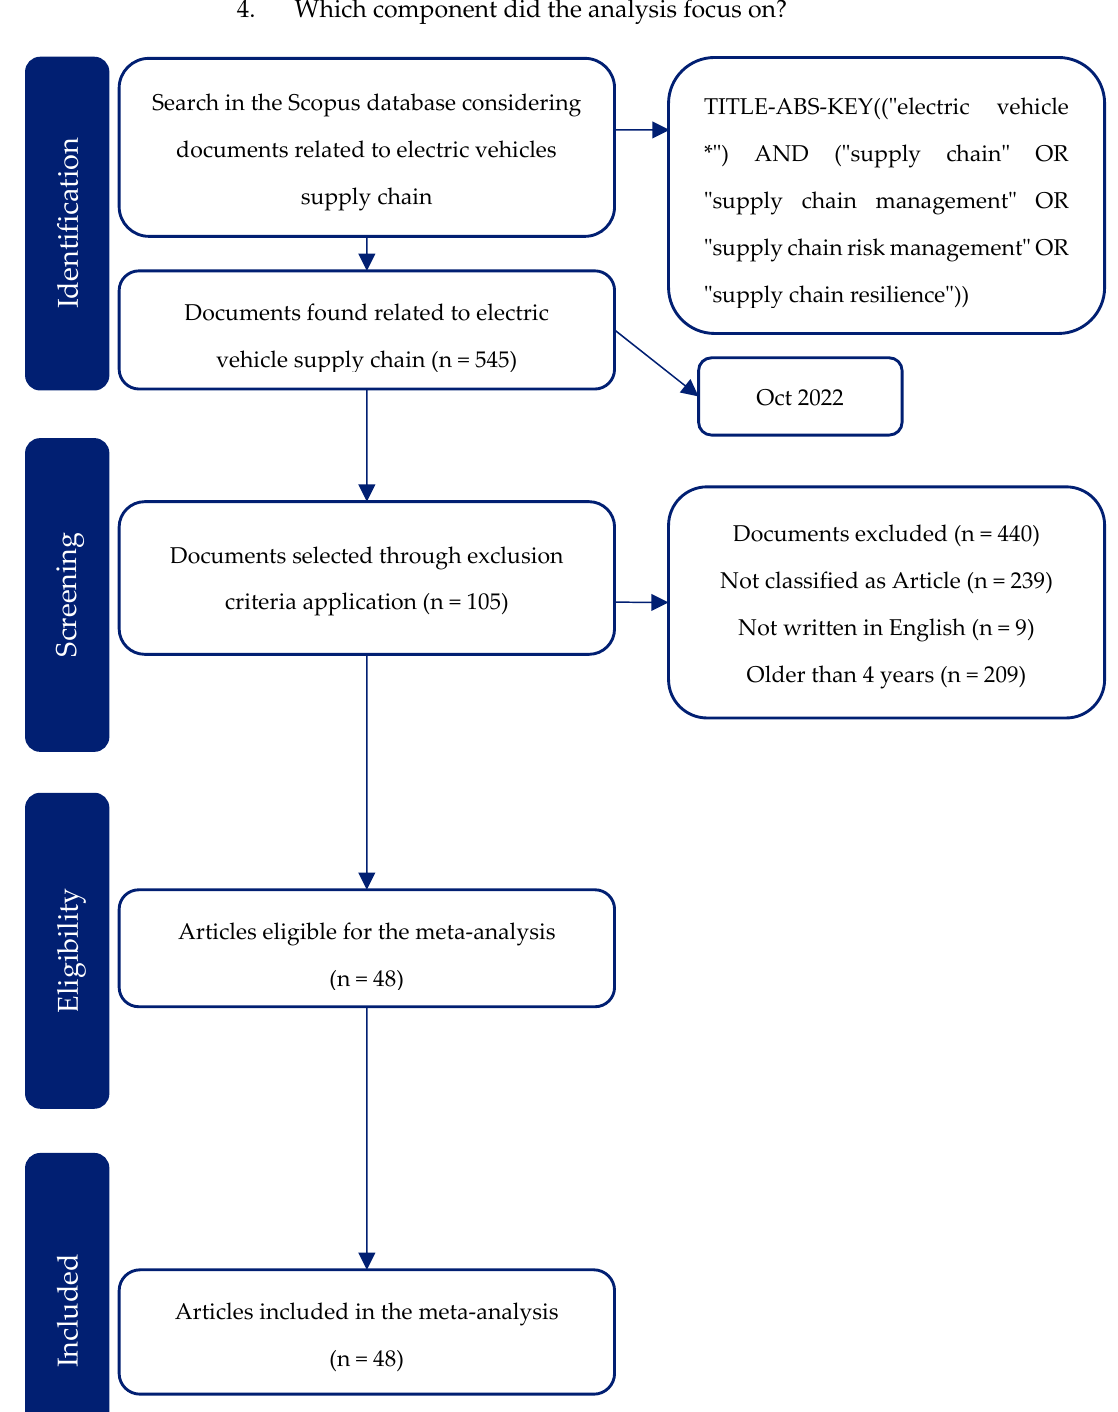
Figure 1. Detailed flowchart illustrating the PRISMA meta-analysis steps. The * was used to find derivations of the word "electric vehicle", such as singular and plural.